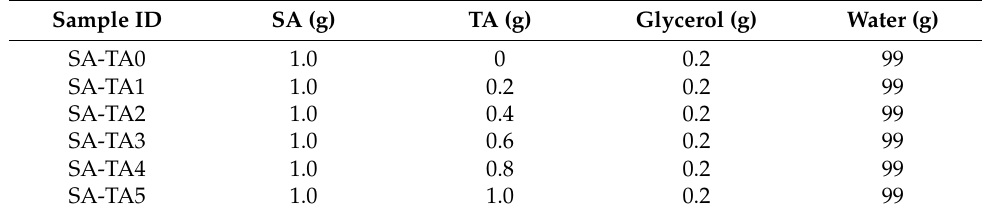
Table 1. Composition of the film forming